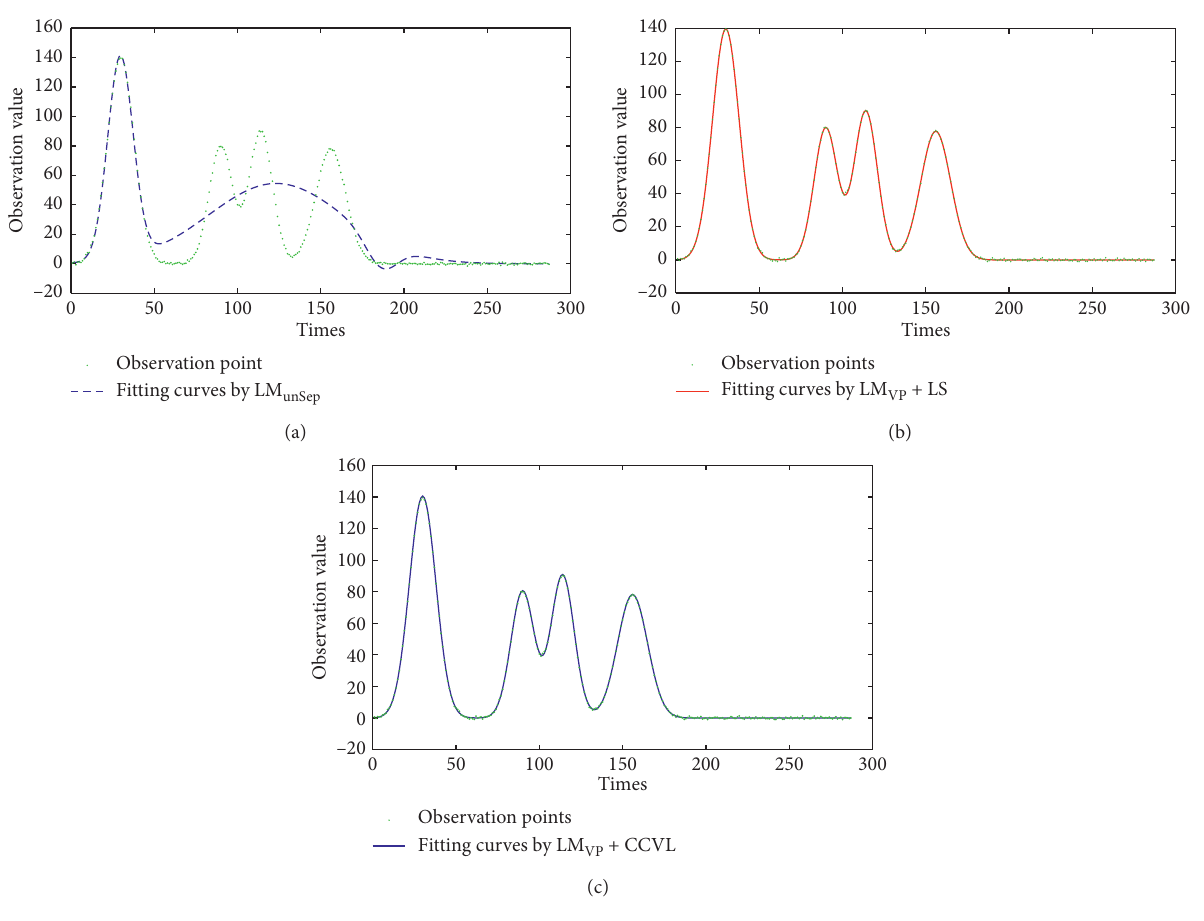
Figure 8: Fitting curves of the LM unSep , LM VP + LS , and LM VP + CCVL methods. Table 7: Comparison of the solution results of the three